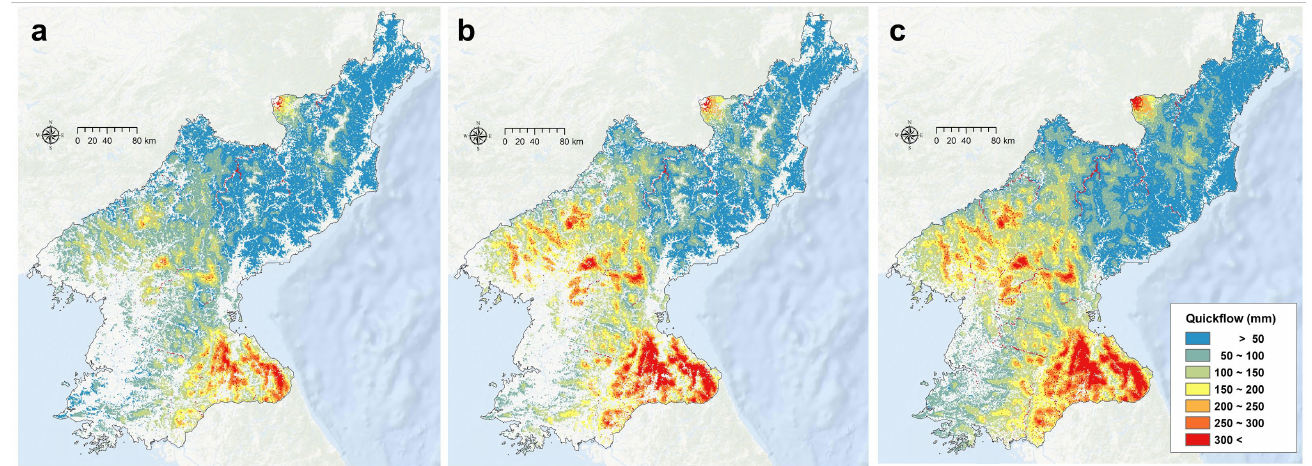
Figure 5. Spatial distribution of QF in forest area: ( a ) baseline period (1981–2010), ( b ) climate change (2041–2070), ( c ) climate and afforestation scenario (Level 3, 2041–2070).